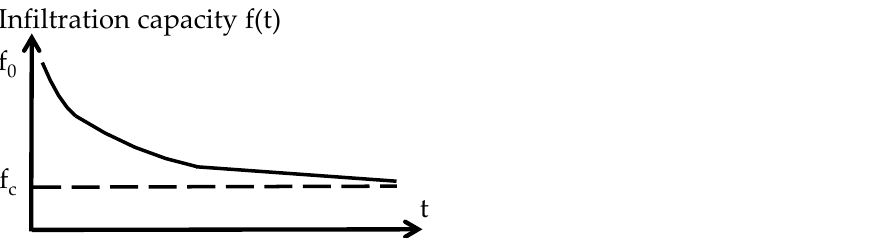
Figure 23. Typical variation in the saturation degree during rainfall tests in this study.